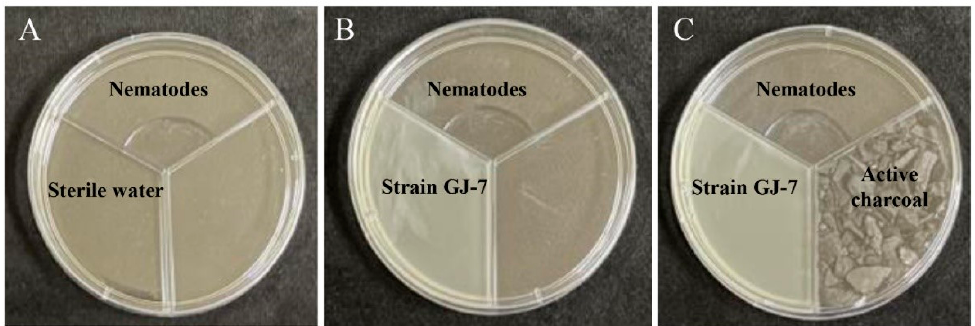
Figure 7. Nematicidal activity of the GJ-7 strain volatile organic compounds (VOCs) in three-com- partment Petri plates ( A – C